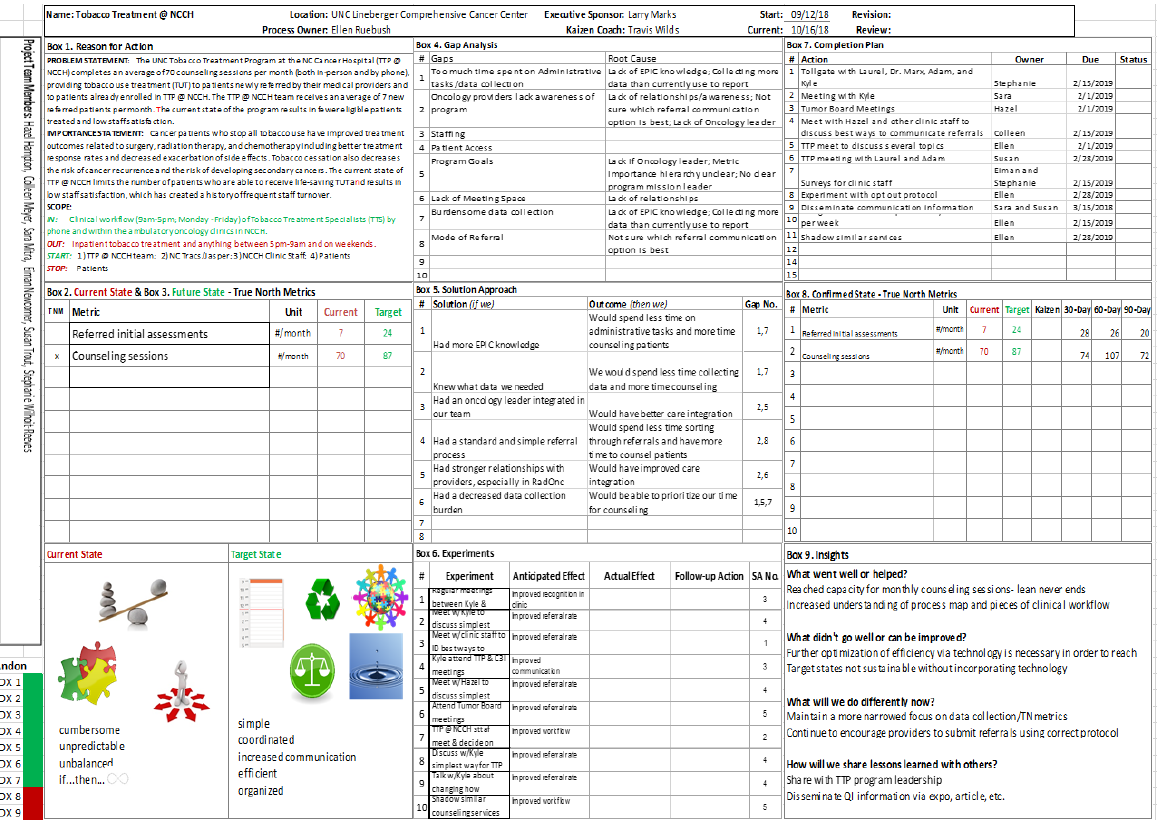
Figure A1. The Lean A3 problem-solving tool demonstrated in this quality improvement initiative. The figure shows the nine steps, or boxes, used in A3 to design, execute, and evaluate the planned project. Abbreviations: TTP, Tobacco Treatment Program; NCCH, North Carolina Cancer Hospital; TUT, tobacco use treatment; TTS, Tobacco Treatment Specialist; RadOnc, Outpatient Radiation Oncology; C3I, Cancer Cessation Initiative; TN, true north; QI, quality improvement.